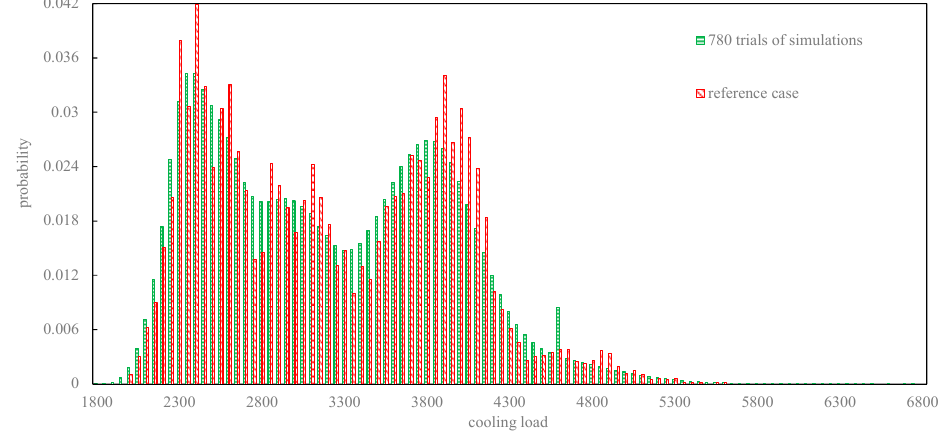
Figure 8. Distribution of cooling load with and without considering uncertainties.